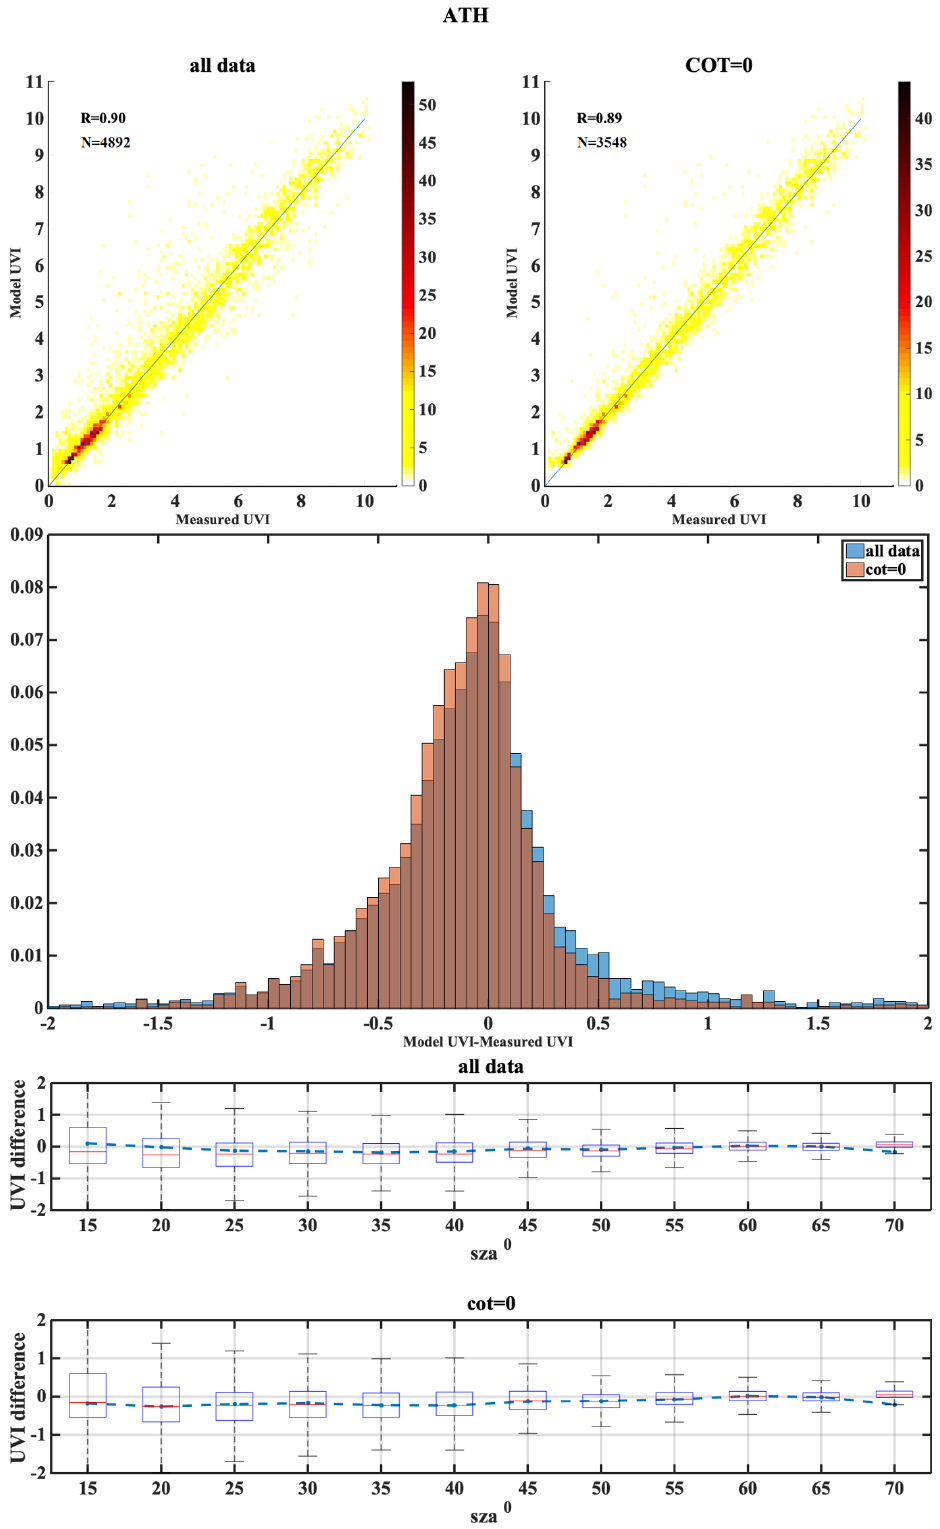
Figure A4. Same as above but for the ATH